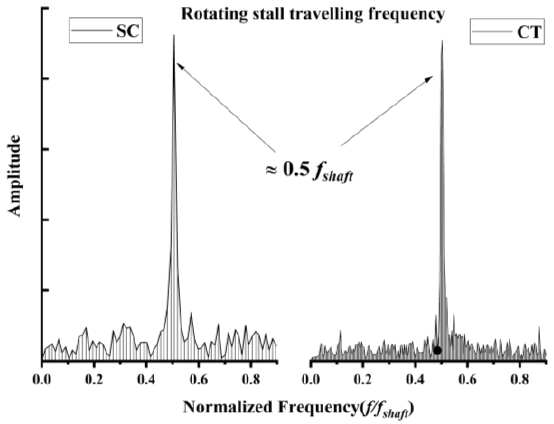
Figure 10. Frequency spectrum of the compressor during the stall process, with and without CT.